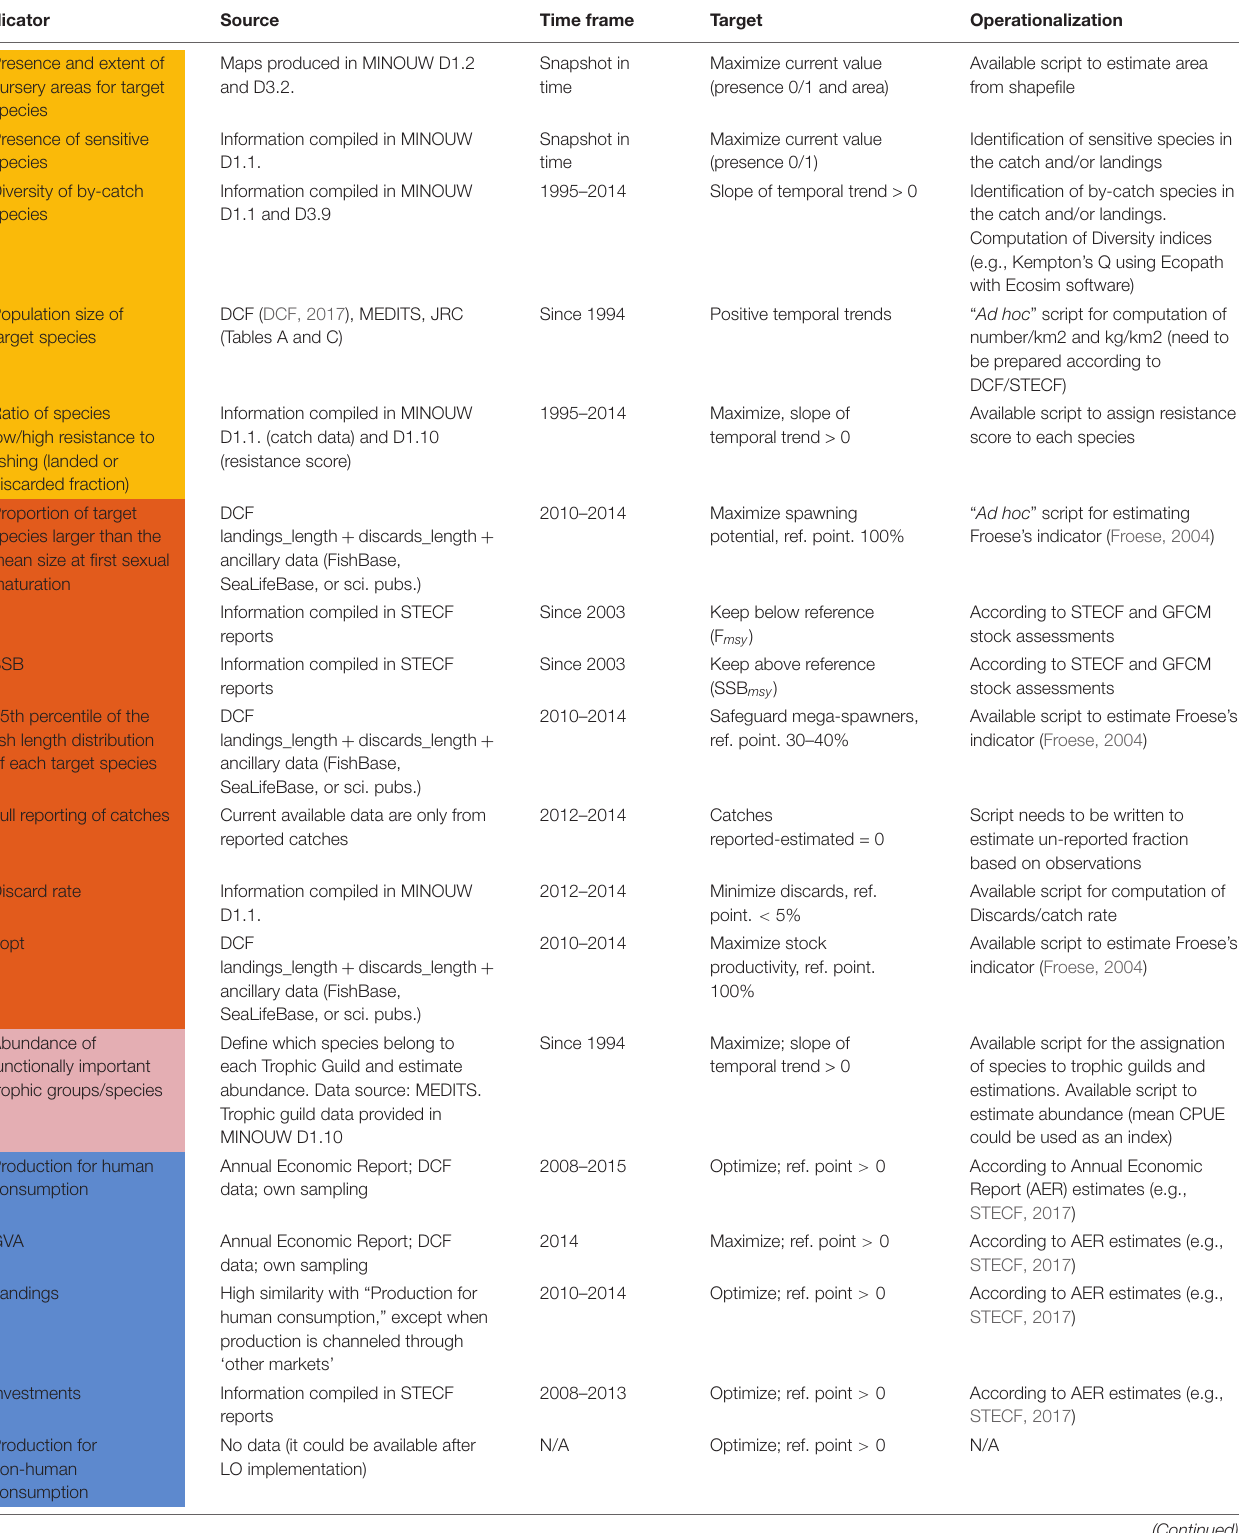
TABLE 3 | Indicators under ranks 1 to 3 and application of the framework in a case study (Demersal otter trawl targeting hake in GSA6): availability of data including current sources of data, time frame available, proposed reference value, operationalization. Indicator Source Time frame Target